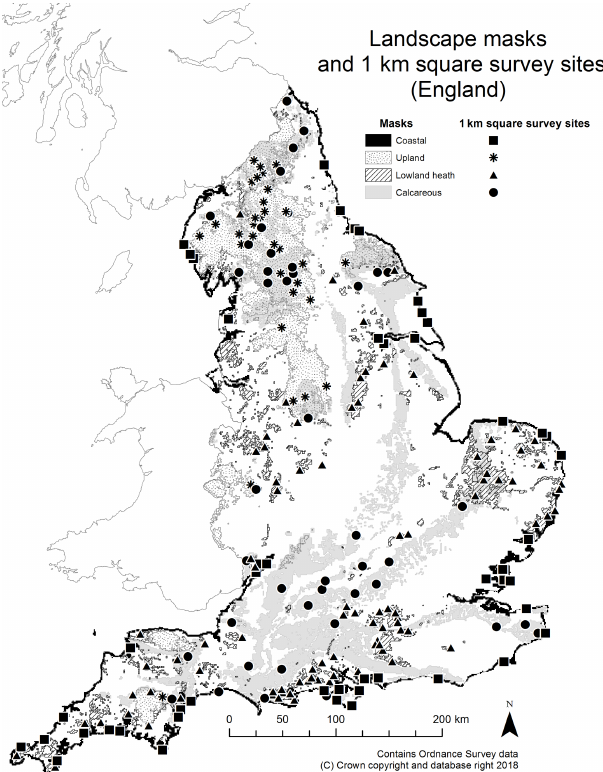
Figure 1. Distribution of spatial landscape masks and 1km square survey